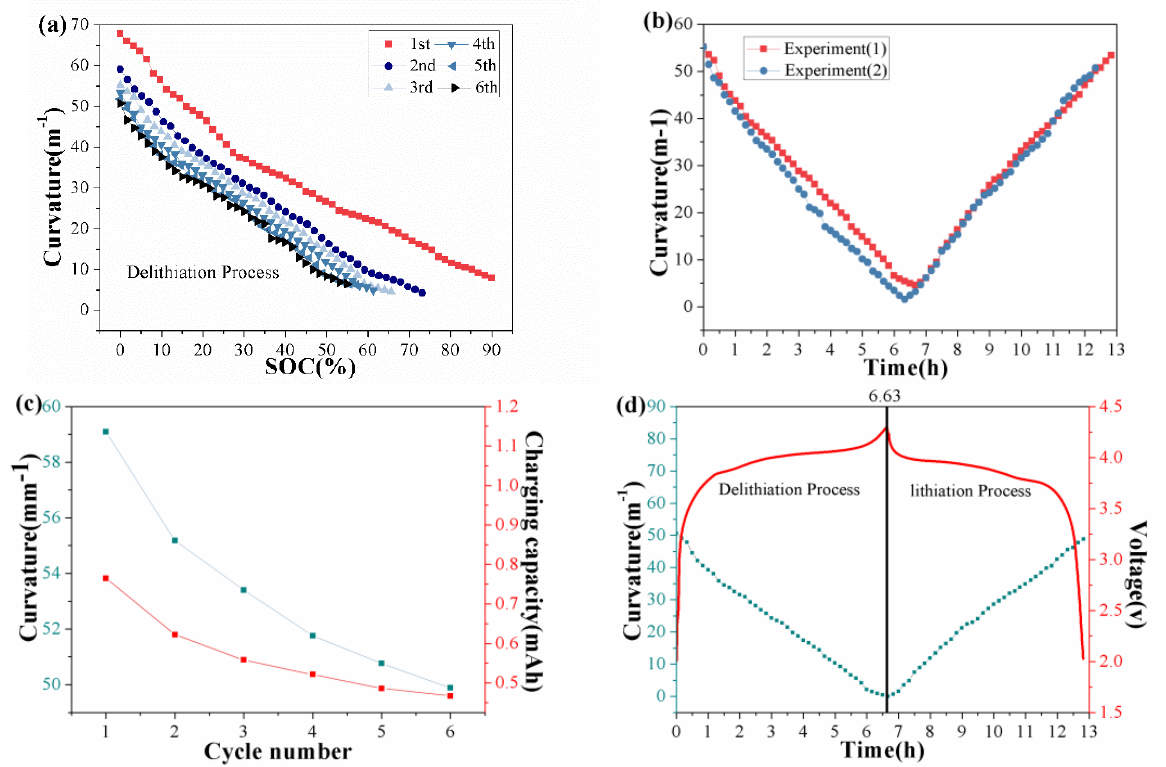
Figure 5. ( a ) Curvature changes of the LiMn 2 O 4 composite electrode in the delithiation process, ( b ) curvature comparison during the third cycle in the different experiments, ( c ) curvature and charging capacity evolution at the end of each cycle, and ( d ) voltage and curvature evolution in the third cycle.